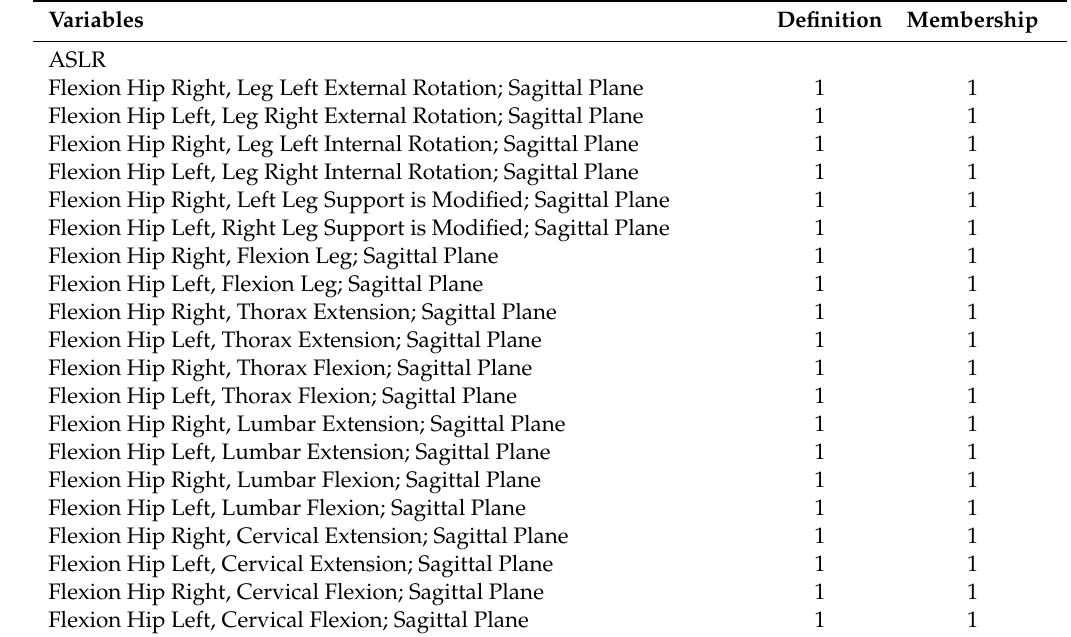
Table 7. Assessment of Aiken V by ten experts of the proposed variables for